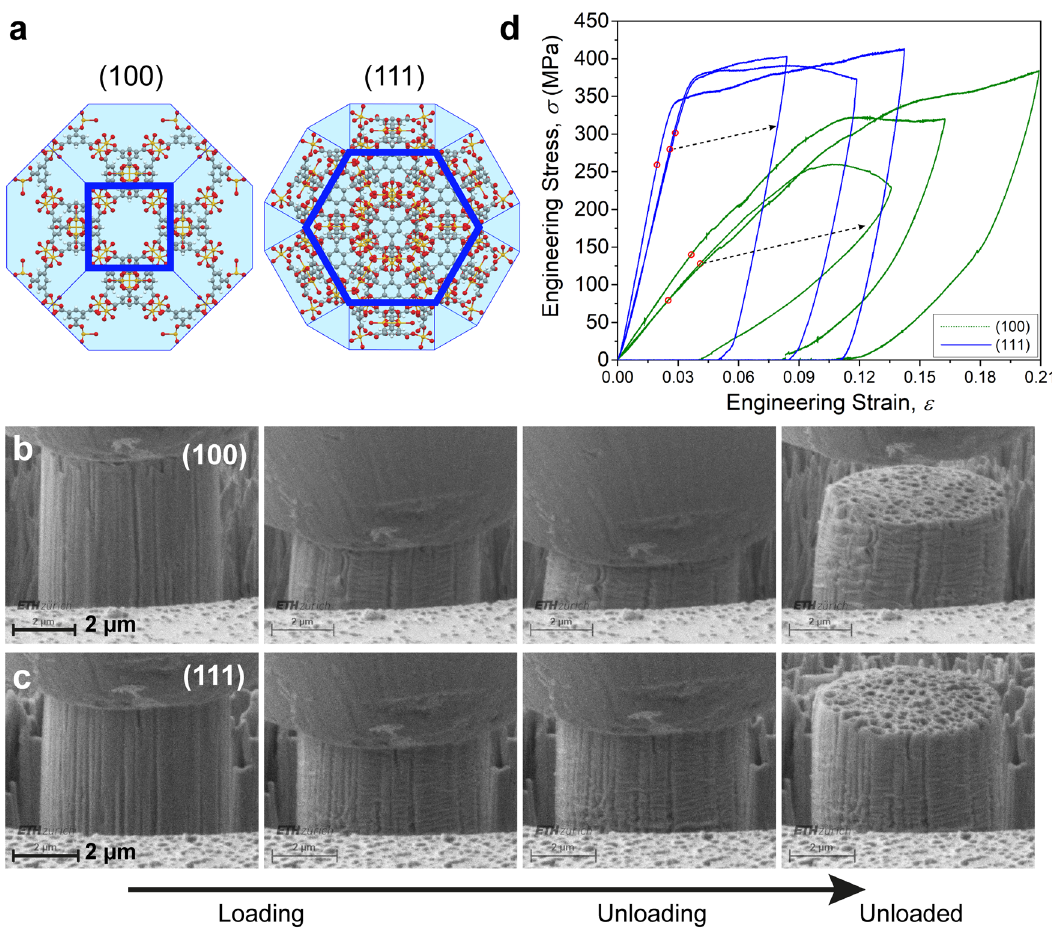
Fig. 1 Uniaxial compression of HKUST-1 micropillars. a Porous crystalline framework of the HKUST-1 MOF structure, viewed down the (100) and (111) crystal facets, respectively. Color code: copper (yellow), oxygen (red), carbon (gray), and hydrogen (white). In the periodic structure, the inorganic copper paddlewheel clusters are bridged by the organic BTC linkers. b , c Scanning electron microscope (SEM) images of HKUST-1 micropillars milled by focused ion beam and subsequently compressed uniaxially with the axis of the fl at punch oriented normal to the ( b ) (100)- and ( c ) (111)-crystal facets, respectively. Recorded videos of the in situ compression tests are given in Supplementary Table 2. d Engineering stress-strain curves obtained from the compression tests on the (100) and (111) crystal facets, showing their distinctively different elastic-plastic deformation behavior. The yield points (red circles) were established using the fi rst-derivative threshold method (see Supplementary Fig. 4 and Supplementary Note